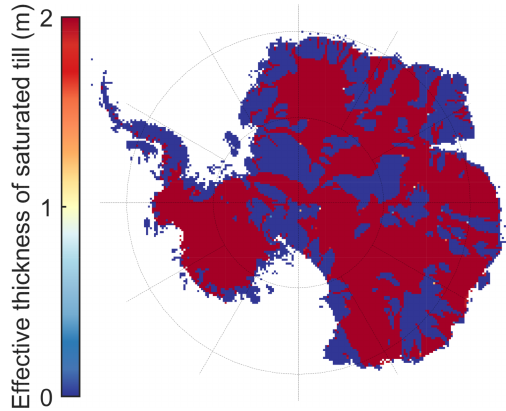
Figure 4. Effective thickness of saturated till (maximum value fixed at 2m) for the TIL